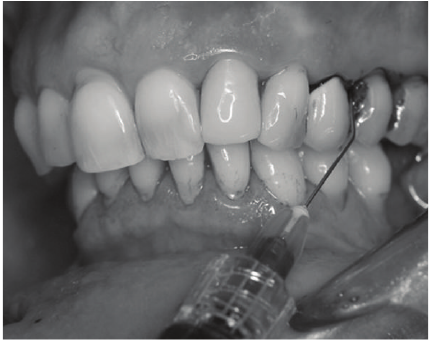
Figure 2: The special HELBO (cid:2) Blue Photosensitizer is applied within the peri-implant pocket starting from the bottom.